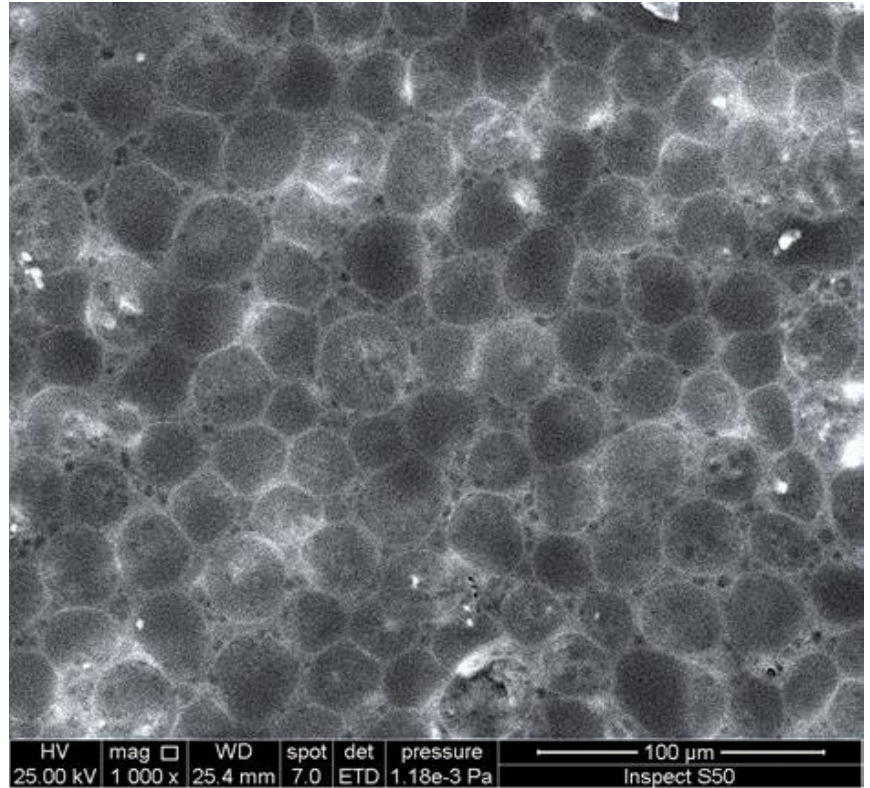
Figure 8. SEM image of the surface of an irradiated PVC film blended with a Schiff base containing a thiadiazole moiety in the presence of nickel chloride.